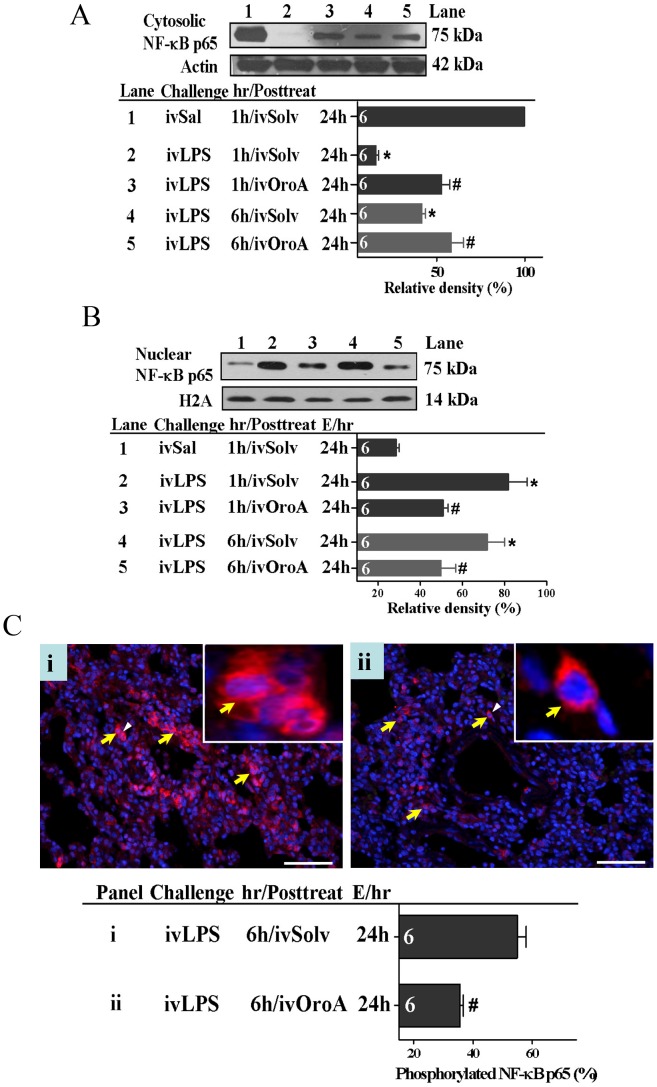
OroA inhibition of LPS-induced NF-κB activation in lung tissue of the rats.LPS treatment (10 mg/kg, iv) significantly decreased cytosolic NF-κBp65 expression in lung tissue (Lane 2 in Fig. 6A) comparing to that by Sal (Saline) followed by Solv (Solvent) treatment (Lane 1 in Fig. 6A). The reduction examined (E) 24 hrs after LPS challenge (Fig. 6A) was significantly reversed to similar extent by treatment with OroA (15 mg/kg, iv) administered 1 hr (Lane 3 in Fig. 6A) or 6 hrs (Lane 5 in Fig. 6A) after LPS. Bar graphs summarized the relative density (%) of cytosolic NF-κB protein that was normalized to actin (Fig. 6A). In parallel, LPS treatment (10 mg/kg, iv) significantly increased nuclear p65 expression (Lanes 2 and 4 in Fig. 6B) comparing to that by Sal followed by Solv treatment (Lane 1 in Fig. 6B). The increase examined 24 hrs after LPS challenge was significantly reversed to similar extent by treatment with OroA (15 mg/kg, iv) administered 1 hr (Lane 3 in Fig. 6B) or 6 hrs (Lane 5 in Fig. 6B) after LPS challenge. Bar graphs summarized the relative density (%) of nuclear NF-κB protein that was normalized to H2A. Solvent (Solv, normal saline plus Tween 80 at 9∶1 ratio); hr/Posttreat (post-treatment hour after LPS treatment); E/hr (examination hour after LPS challenge). Data are means ± SEM. *P<0.05 indicates significant difference from the normal control (Sal followed by Solv, Lane 1 in panels A and B). #P<0.05 indicates significant difference from the respective LPS treated group (LPS followed by Solv) (Lanes 2 and 4 in Figs. 6A and 6B) when examined 24 hrs after LPS challenge. The number in each column represents the number of rats examined. Fig. 6Ci indicates effects of LPS (10 mg/kg, iv) administered 6 hrs after LPS challenge on phosphorylated p65 cells in red (indicated by yellow arrows in panels Ci and Cii) which were examined 24 hrs (E/24h) after LPS challenge. Phosphorylated NF-κB p65 cells were significantly reduced by OroA (15 mg/kg, iv) administered 6 hrs after LPS challenge (panel Cii). Phosphorylated NF-κBp65 cells were calculated from randomly selected 4 fields with a total of 200 cells. Insets are enlarged areas indicated by white arrowheads denoting phosphorylated NF-κBp65 translocated into the nuclei. The nucleus in blue color was stained with DAPI. Data are means±SEM. #P<0.05 indicates significantly different from the LPS plus Solv-treated group. Scale bar, 20 µm. The number in each column represents the number of rats examined.